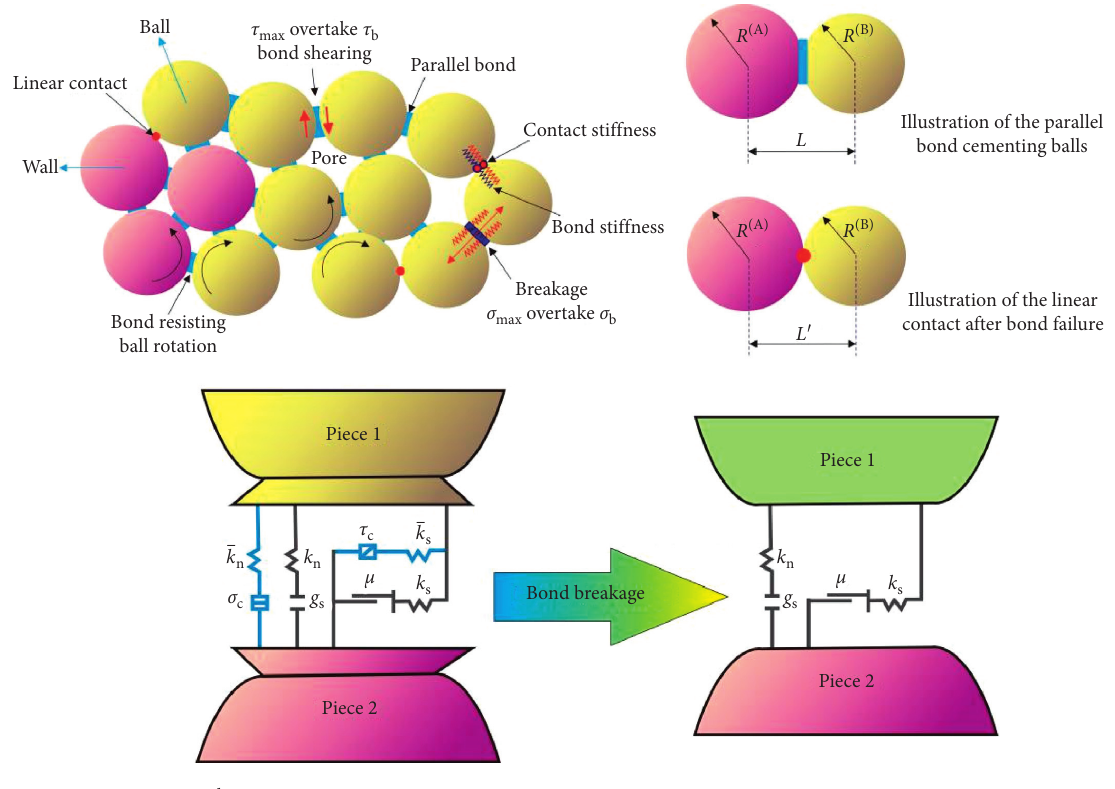
Figure 4: Illustration of the parallel bond model